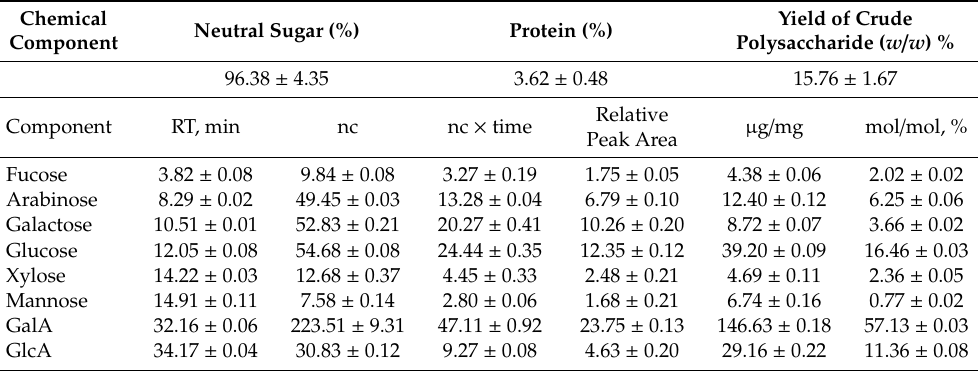
Table 1. The chemical components of polysaccharides fractionated from alfalfa 1 .